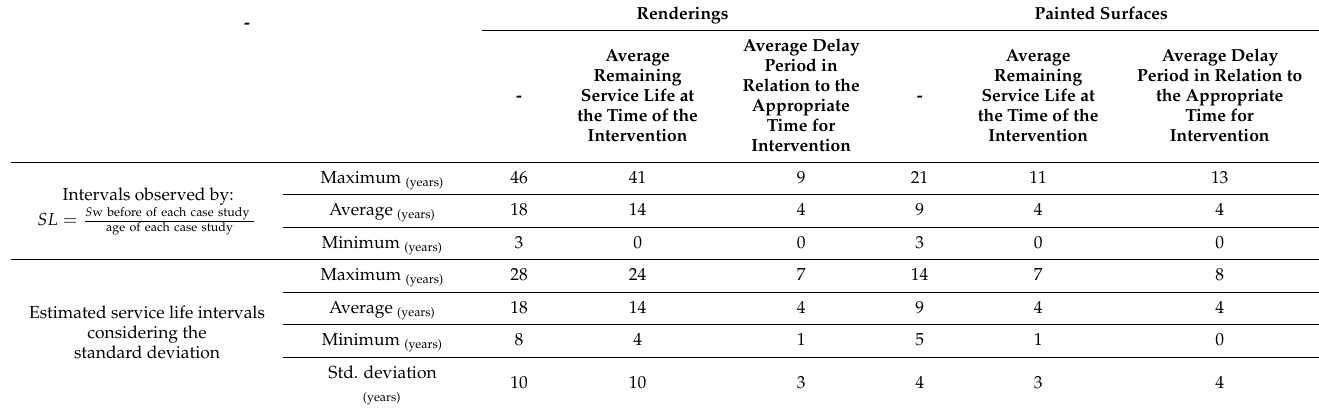
Table 4. Summary of the estimated service life and the time when the maintenance action was